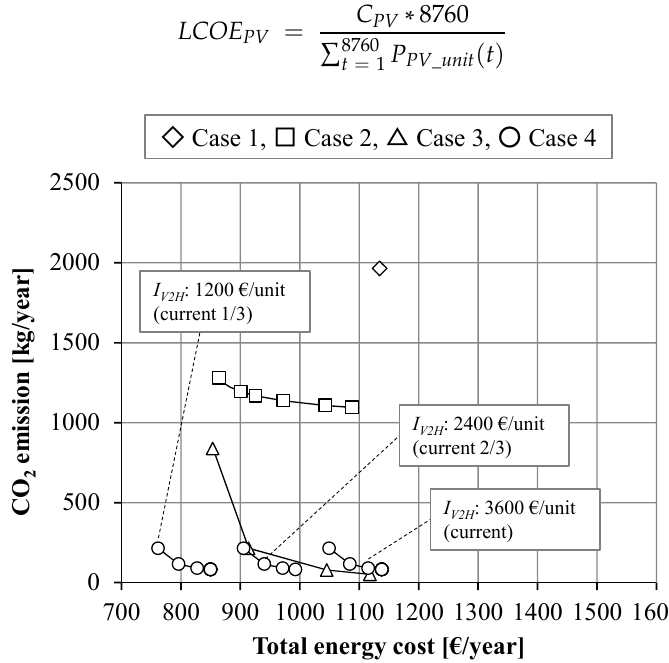
Figure 7. Pareto solution of the cost and amount of CO 2 emission for the cases of non-commuter EV.